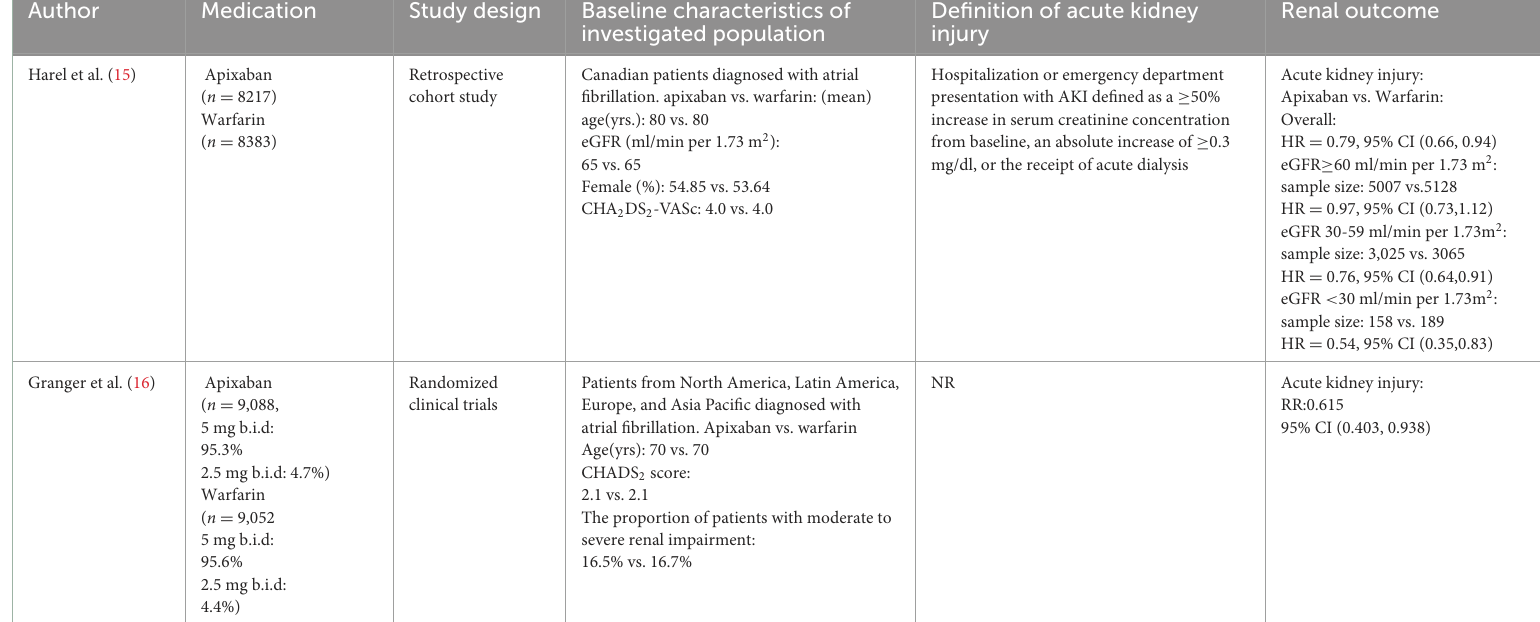
CHADS 2 score: 2.1 vs. 2.1